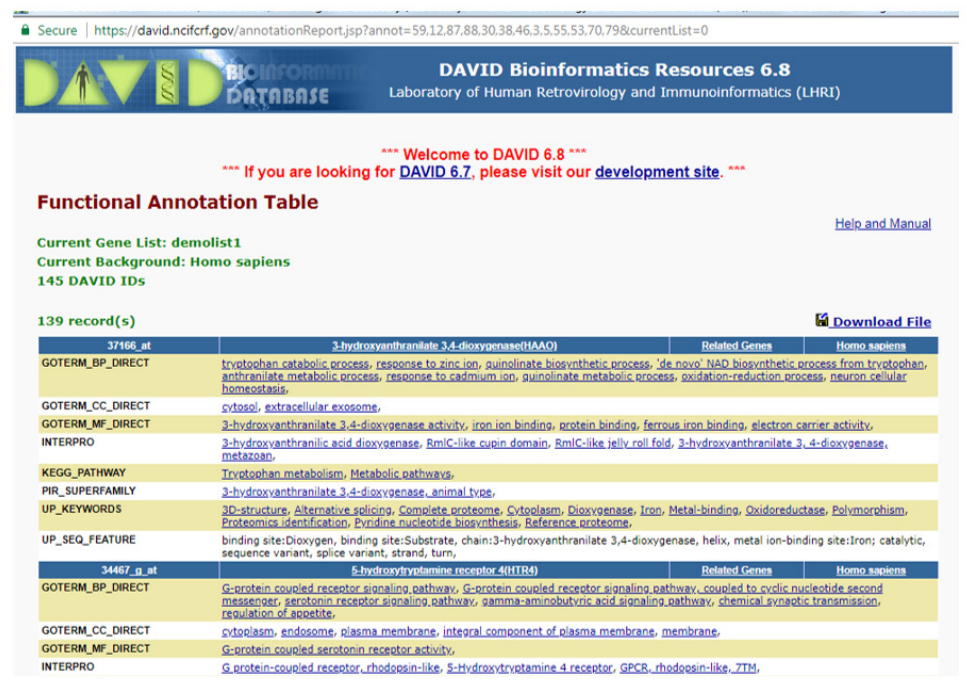
Figure 6. Interpreting the output. Screenshot of the DAVID “Functional Annotation Table” results for a geneset Top left: (blue bar): Gene Symbol identifier. Center (blue bar): full gene name. Labels (left): GO Term BP, GO Term CC, and GO Term MF descriptors. Note that these descriptors are